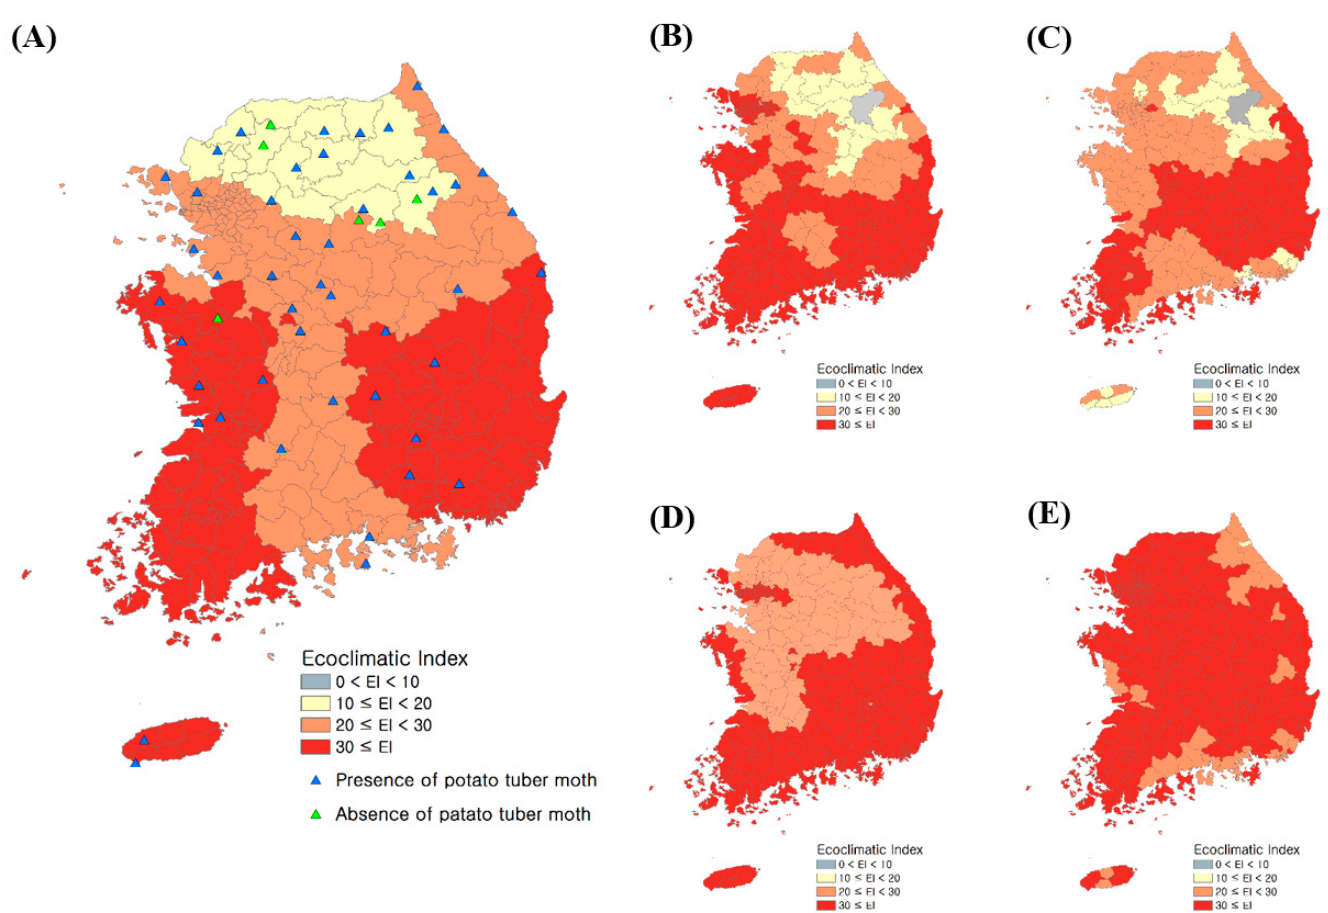
Figure 4. Potential distribution maps of potato tuber moths for the current climate and other climate change scenarios (( A ) = current; ( B ) = 2040; ( C ) = 2060; ( D ) = 2080; ( E ) = 2100).